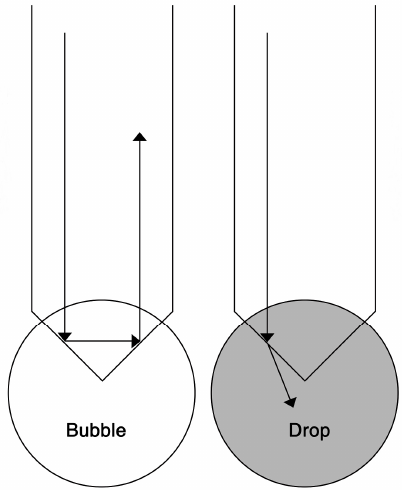
Figure 2. Response principle of optical fiber probe tip.